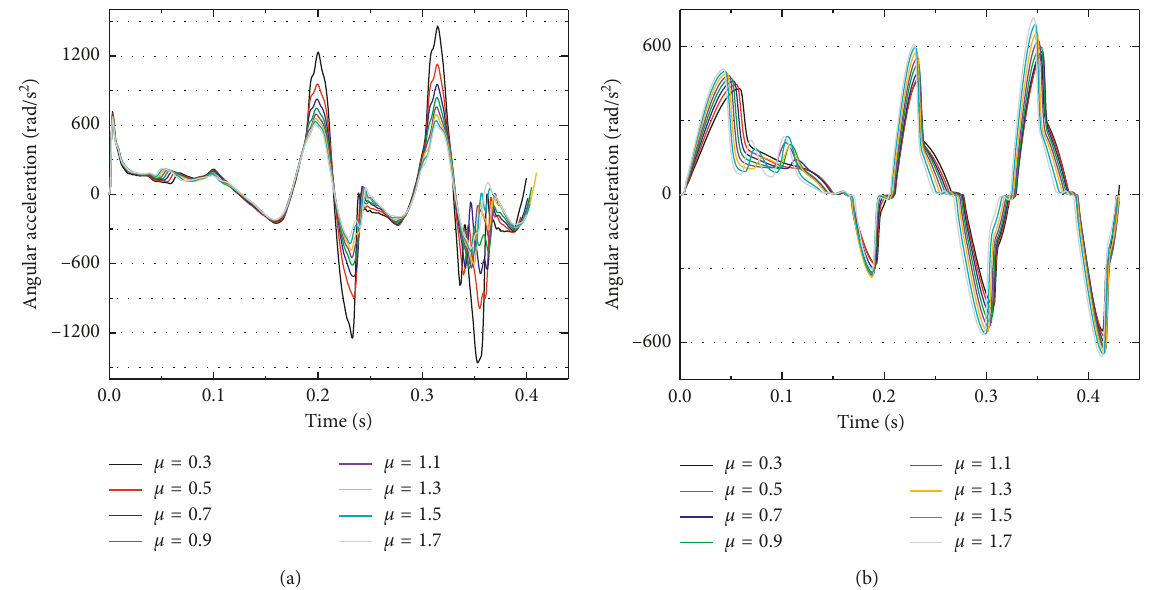
Figure 11: Angular acceleration under different μ values in Phase A. (a) The primary side result; (b) the secondary side result.